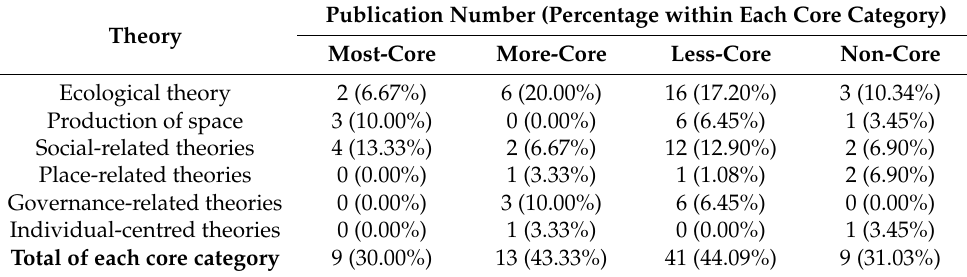
Table 3. Number of each type of core publication in each theoretical group.